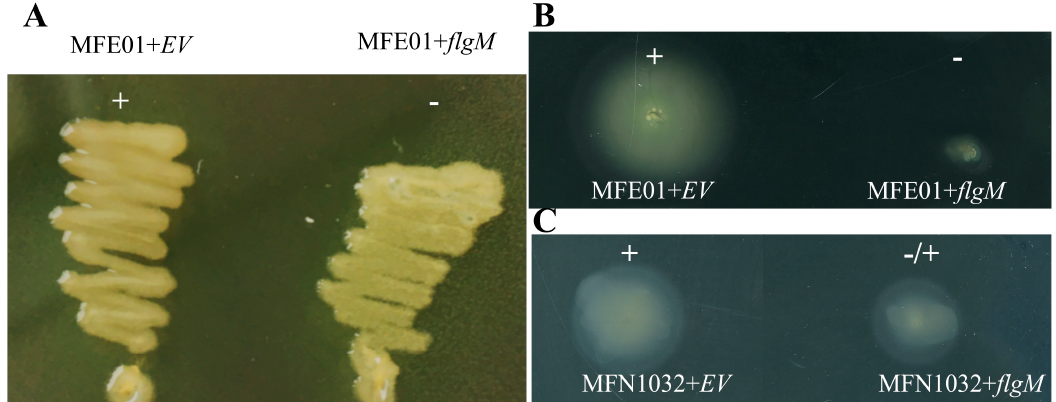
Figure 8. Phenotypic e ff ects of flgM overexpression in MFE01 and MFN1032. ( A ) Mucoid phenotype of MFE01 + flgM . Mucoidy was assessed on 1.5% LB-agar, supplemented with 50 µ g / mL gentamycin, after incubation for 24 h at 28 ◦ C. EV: empty pJN105 vector, + : mucoid, − : non-mucoid. The images shown are representative of three assays ( n = 3). ( B ) Swimming motility of MFE01 + flgM . Swimming assays were performed on 0.3% LB-agar, supplemented with 1% arabinose and 50 mg / mL gentamycin at 28 ◦ C. ( n = 3). − : non-motile, + : motile, EV: empty pJN105 vector. The images shown are representative of three assays. C. Swimming motility of MFN1032 + flgM . Swimming assays were performed on 0.3% LB-agar, supplemented with 1% arabinose and 50 mg / mL gentamycin at 28 ◦ C. − : non-motile, + : motile. EV: empty pJN105 vector. The images shown are representative of three assays.